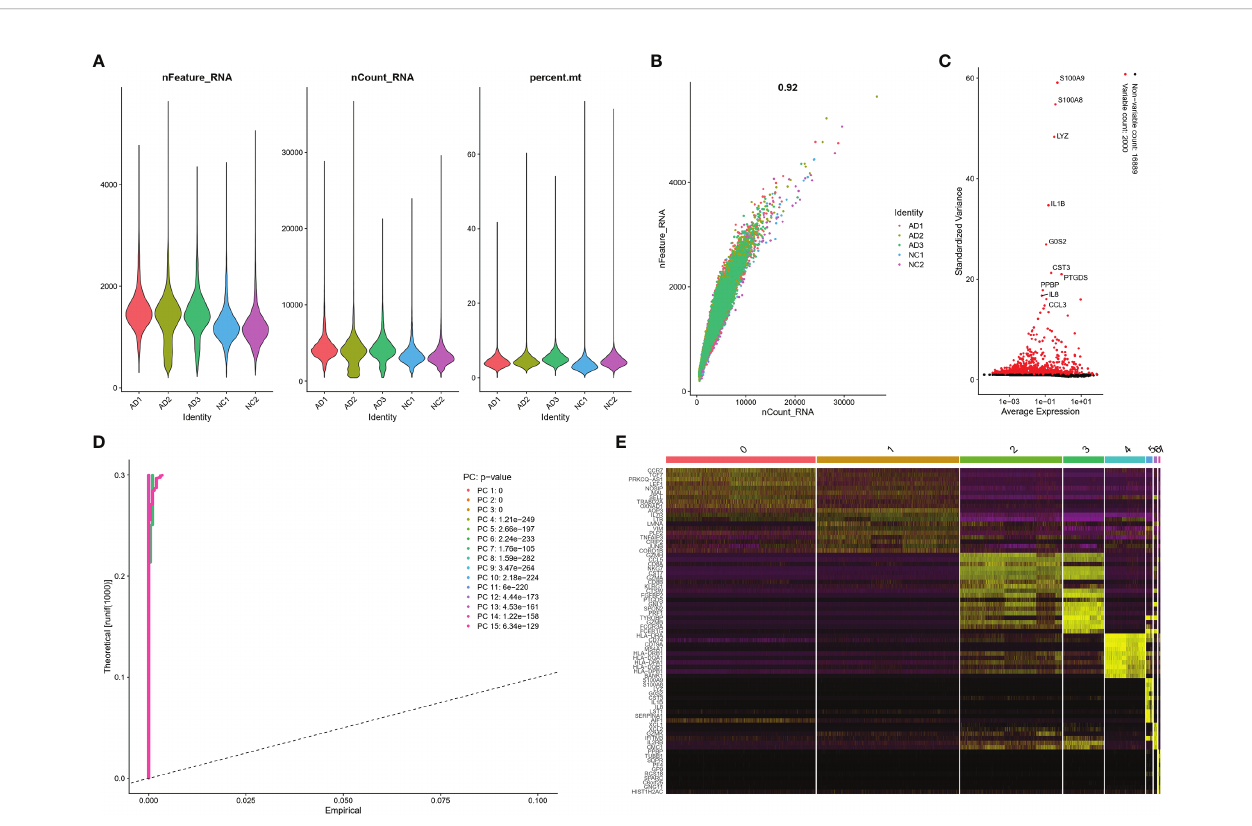
FIGURE 1 | scRNA analysis of PBMCs in AD. (A) The genes (features), counts, and mitochondrial gene percentage of each sample. (B) Correlation between genes and counts in each sample. (C) HVGs were colored in red, and the top 10 HVGs were labeled. (D) PCs selection using JackStraw function. (E) Heatmap of top 10 DEGs in each cluster. The top 10 DEGs were labeled in yellow color.